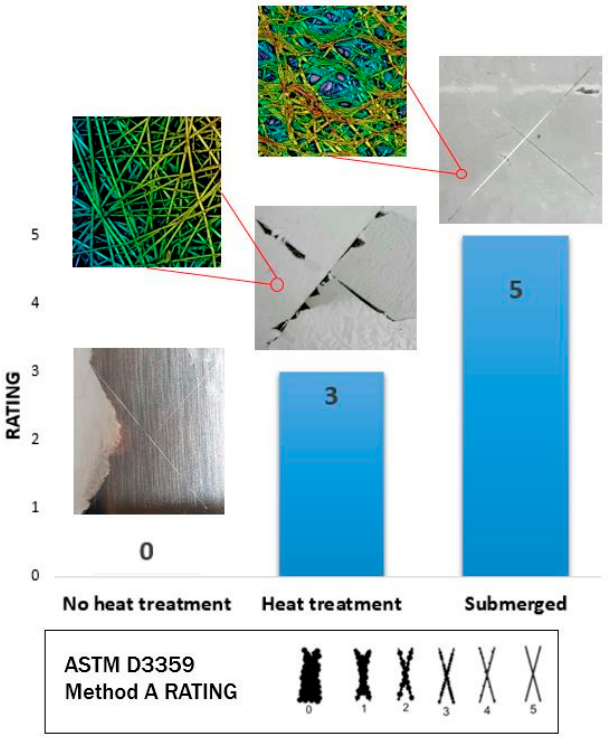
Figure 4. Aspect of the X-cut adhesion tests for the electrospun PAA + β -CD before thermal treatment (rating 0), after thermal treatment (rating 3) and after combining both thermal treatment and water immersion (rating 5) according to ASTM D3359 Method A Rating.